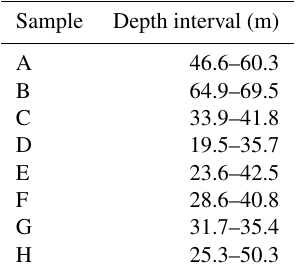
Table 2. Slotted depth intervals for the 8